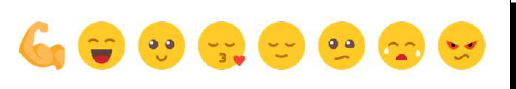
Figure 3. The emotional states are selectable in